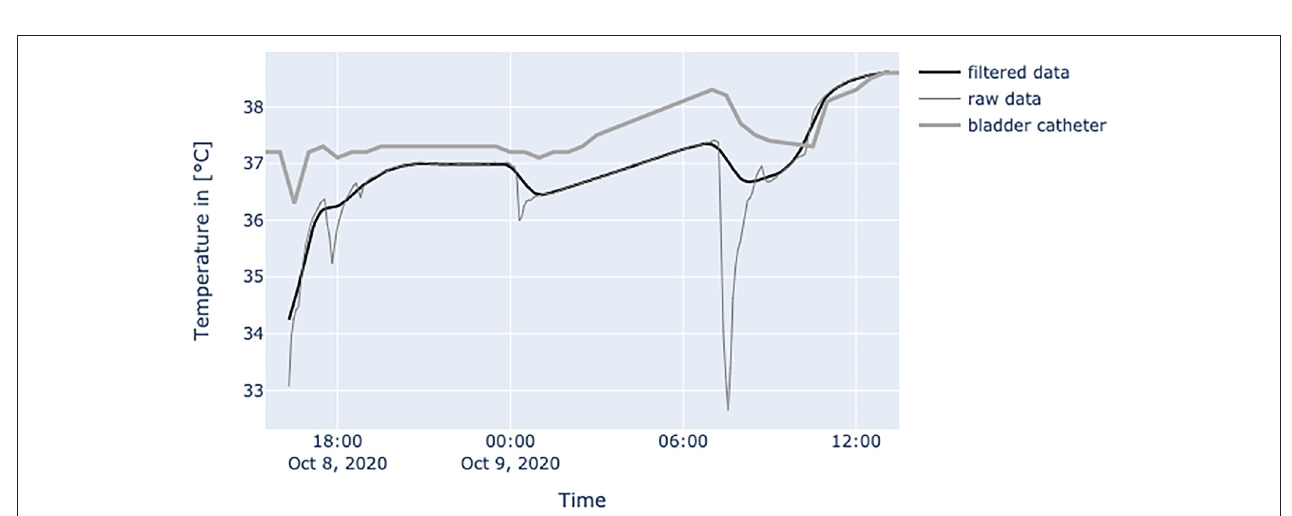
FIGURE 10 | Diagram shows a patient with high vasopressor usage (norepinephrine: 0.401 µ g/kgBW/min, terlipressin: 0.02409 µ g/kgBW/min) and nearly no movement inside bed. Terlipressin was discontinued at 08:00 and norepinephrine was cut in half at 09:00 (0.2008 µ g/kgBW/min). After that intervention, the patch’s temperature values adjusted to core